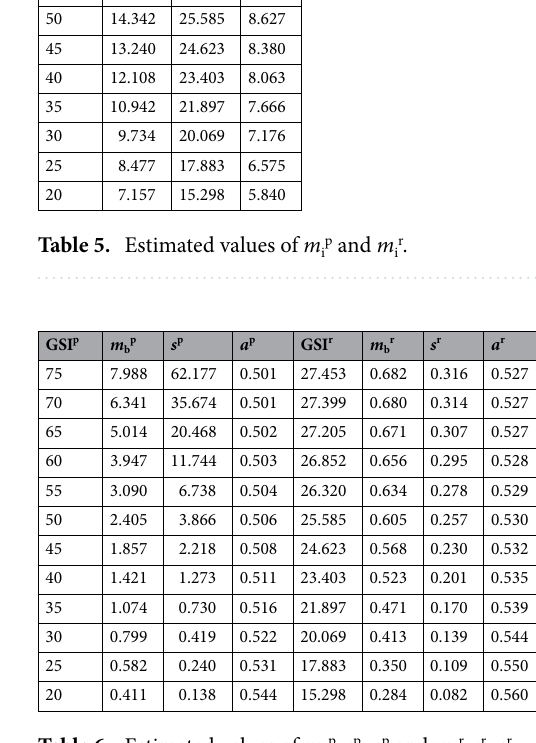
Table 6. Estimated values of m b p , s p , a p and m b r , s r , a r .